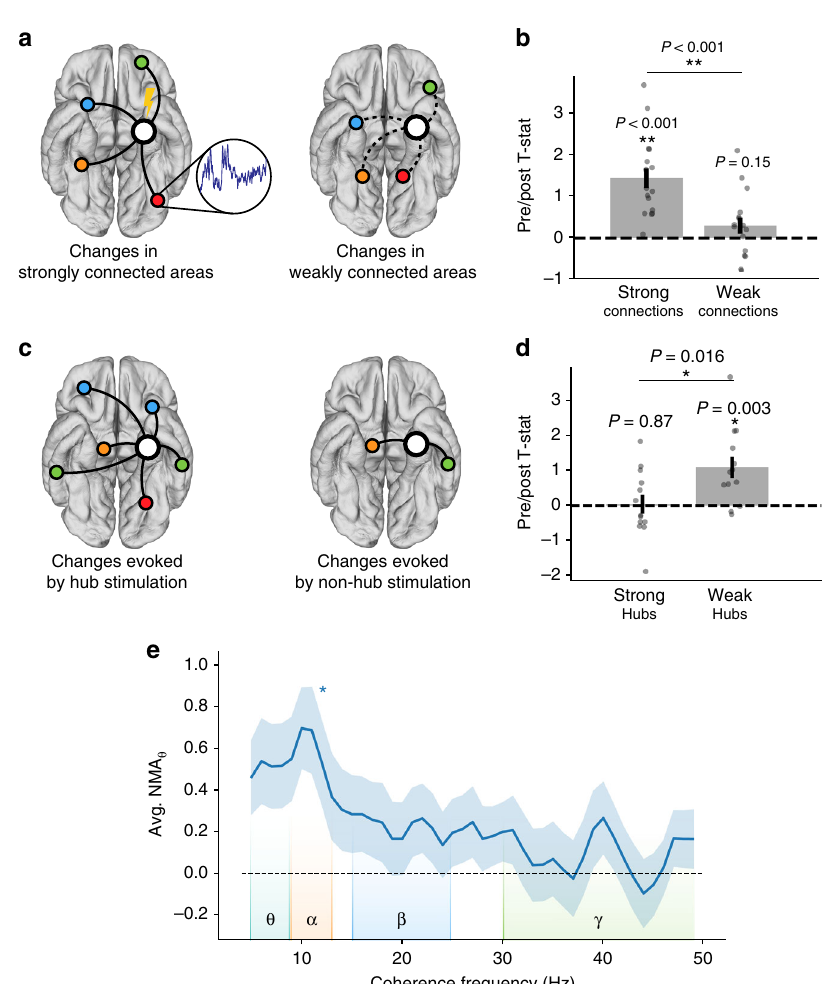
Fig. 4 Network properties of stimulation-induced theta. a Schematic of a stimulation site and its most strongly connected areas (left) or weakly connected areas (right). b For each of 16 stimulation sites with signi fi cant NMA θ ( P < 0.05), the average post- vs. pre-stimulation theta t -statistic is computed for the fi ve strongest-connected electrodes and the fi ve weakest-connected electrodes (controlled for distance). Strongly connected regions are typically areas of the lateral temporal, prefrontal, or inferior parietal cortices. Changes at strongly connected recording sites are signi fi cantly greater than changes at weakly connected sites (paired t -test, t (15) = 6.03, P = 1.7 × 10 – 5 ). c Schematic of a hub-like stimulation site (left) and a non-hub stimulation site (right). Hub scores are calculated as the node strength, or average of all connection weights to a given electrode. d For each of 40 stimulation sites in or near white matter, the average post- vs. pre-stimulation theta t -statistic is computed for the fi ve strongest-connected recording electrodes. Stimulation of a weak hub (lower tercile of hub scores, n = 13) yields signi fi cantly greater change in connected regions than stimulation of a strong hub (upper tercile of hub scores, n = 14) (two-sample t -test, P = 0.016). e Average NMA θ across all in or near-white matter stimulation sites, as a function of functional connectivity frequency. NMA θ is greatest for networks constructed from theta or alpha coherence (5 – 13 Hz). Corrected for multiple comparisons across all frequencies, NMA θ is signi fi cantly greater than zero at 11 Hz. Error bars show ±1 SEM; * P < 0.05; ** P < We fi rst assessed whether stimulation evoked any detectable modulation of power in the alpha/beta, gamma, and HFB bands, regardless of relationship to connectivity. To do this, we averaged the pre- vs. post-stimulation t -statistic across all electrodes in each subject ’ s brain, for each frequency band. The result is an average t -statistic re fl ecting the stimulation-evoked whole-brain change in power at each frequency band. Across all stimulation sites, stimulation signi fi cantly increased power in the theta, alpha/ beta, and gamma bands, but signi fi cantly decreased power in the HFB range (one-sample t -test, false discovery rate (FDR)- corrected P < 0.05; Fig. 6a – c). However, the power response to stimulation was not uniform across electrodes within a subject; for electrodes that exhibited a strong theta response, evoked changes were weaker at higher frequencies (Fig. 6d), indicating a theta-speci fi c effect.